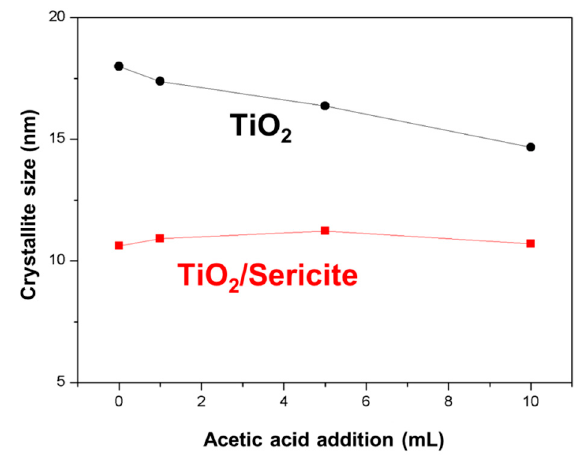
Figure 2. Crystallite sizes of the prepared TiO 2 and TiO 2 / sericite photocatalysts.